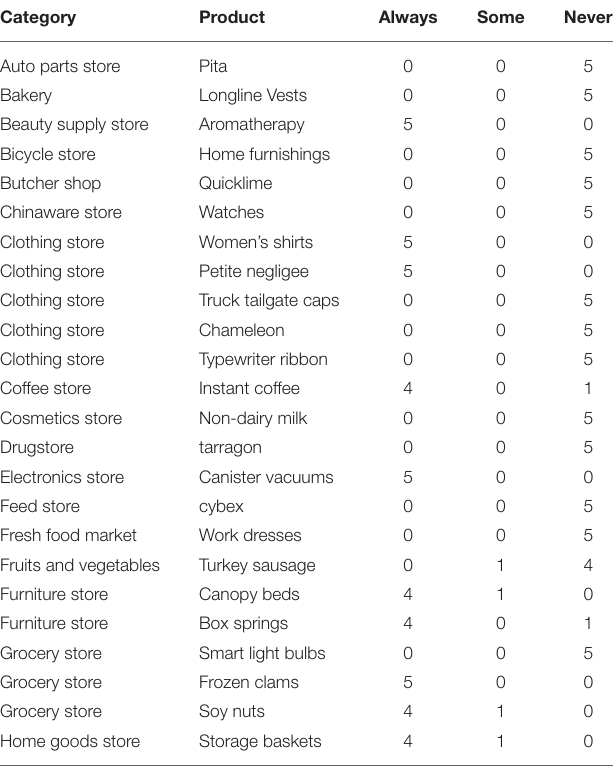
TABLE 2 | Example CrowdSense ratings on R C pairs. Category